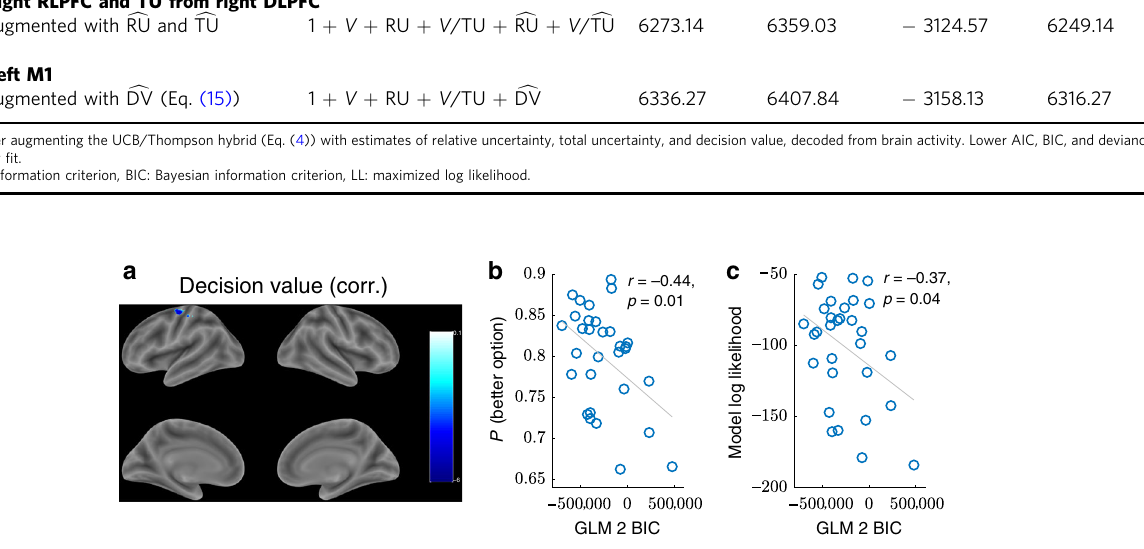
Fig. 5 Primary motor cortex tracks decision value. a Whole-brain ∣ DV t ∣ contrast from GLM 2. Single voxels were thresholded at p < 0.001 and cluster FWE correction was applied at signi fi cance level α = 0.05. The ROI in left primary motor cortex (left M1; peak MNI [ − 38 − 8 62]) was used in the subsequent con fi rmatory analysis (10 mm sphere around the peak voxel). b Cross-subject Pearson correlation between the BIC in left M1, quantifying the extent to which neural activity in that region is captured by GLM 2 (lower BIC indicates better fi t), and average performance. c Cross-subject Pearson correlation between the BIC in left M1 and model log likelihood, quantifying the extent to which the subject's choices are consistent with the UCB/Thompson hybrid model. r : Pearson correlation coef fi